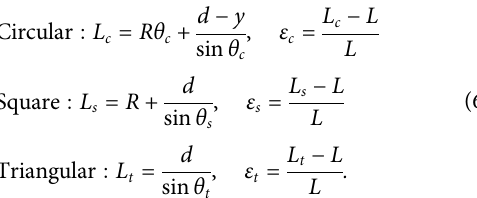
Frontiers in Robotics and AI |